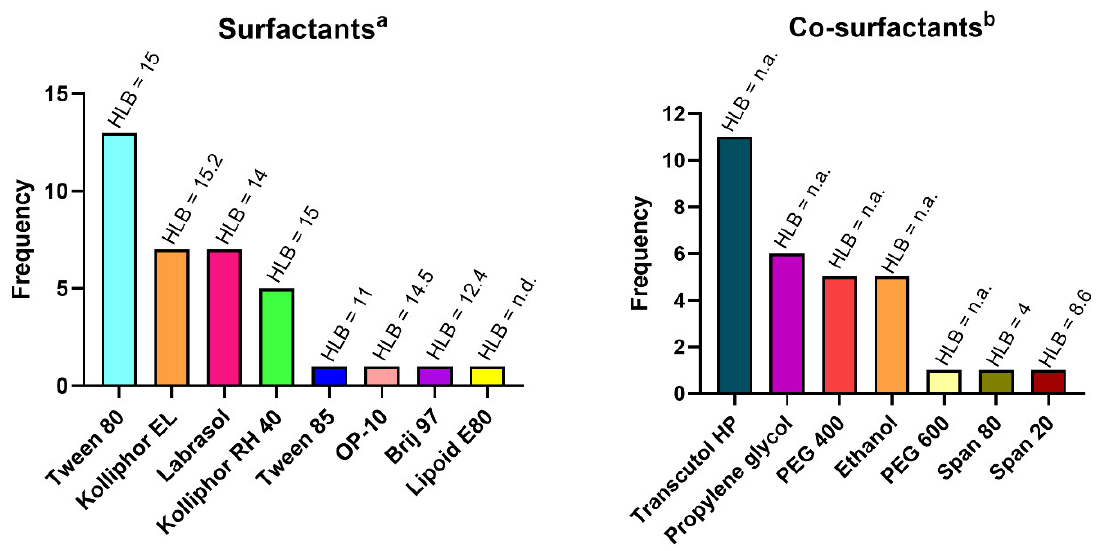
Figure 1. Frequency of surfactants ( a hydrophilic surfactants with HLB > 10) and cosurfactants ( b hydrophobic surfactants and organic solvents used other than oils with HLB < 10) used in the preparation of self-emulsifying drug delivery systems (SEDDS) described in the revised articles. Hydrophilic–lipophilic balance (HLB) is described for each excipient, except for those that are not determined (n.d.) or not appliable (n.a.). Created with GraphPad Prism software, version 8.0 (San Diego, CA,